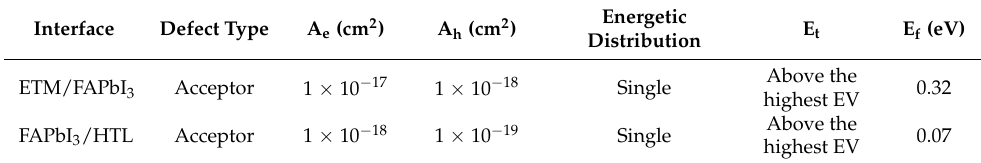
Table 3. Defect parameters of ETM/perovskite and perovskite/HTL interfaces, as extracted from Ref. [41].